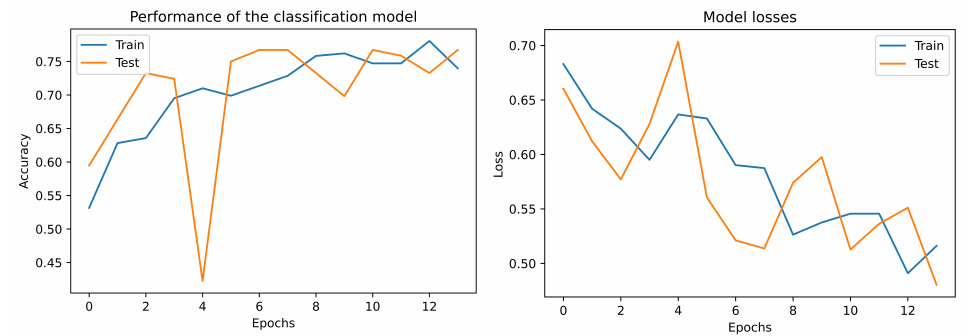
Figure 7. Loss and accuracy over the train and test data in the 2D-Convolutional neural network proposed with unbalanced data.